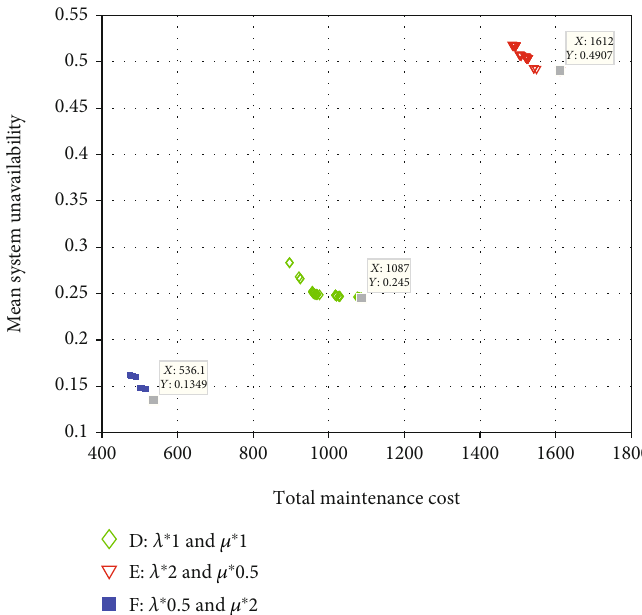
Figure 15: Pareto frontier for second-level human